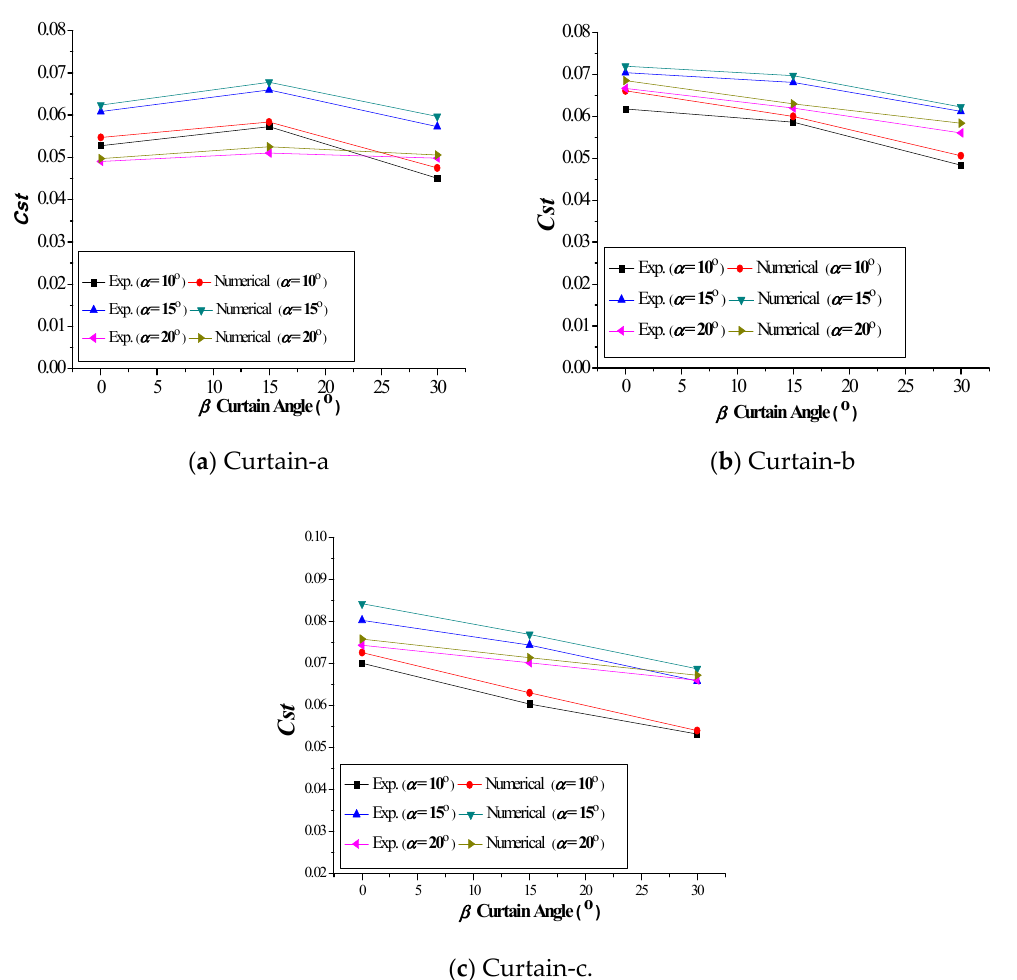
Figure 16. Static torque coefficients of ( a ) Curtain-a, ( b ) Curtain-b and ( c ) Curtain-c ( θ = 165°).